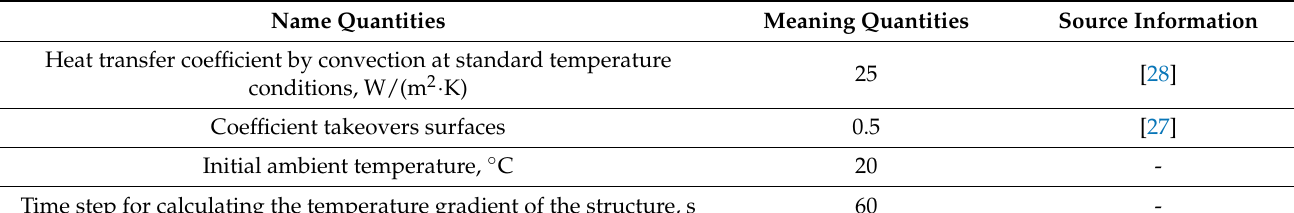
Table 3. Boundary conditions defined in the SP QuickField.